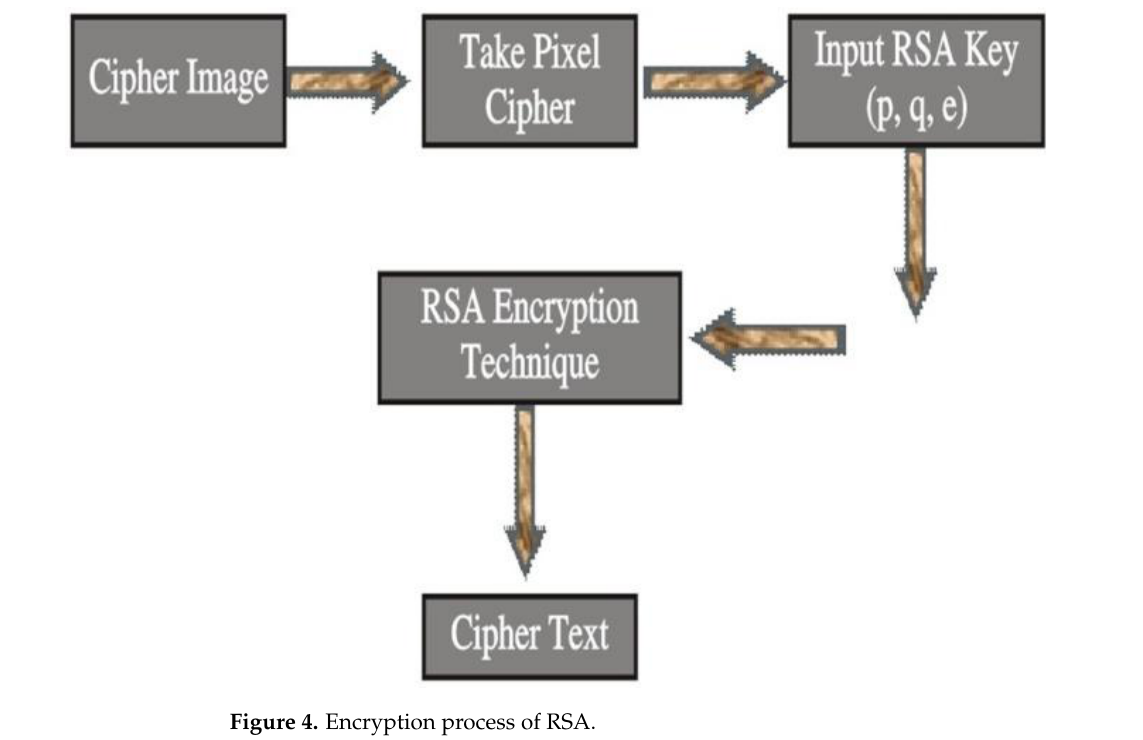
Figure 4. Encryption process of RSA.